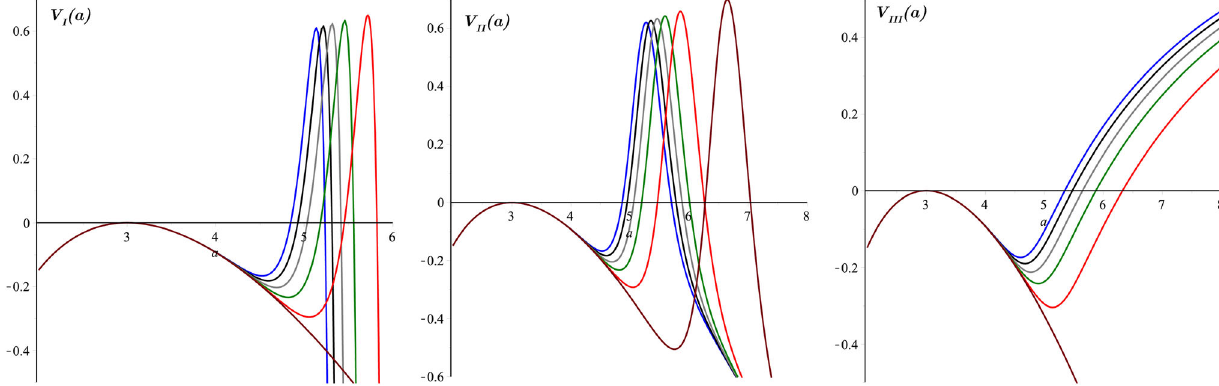
Fig. 10 Acloserlookatthepotentials V I , V II and V III withverysmall initial velocity i.e., v 0 (cid:3) 1 and a = 3 M , M = 1 and β 2 and − 16 for V I , V II and V III respectively. For all three potentials the value of the initial velocity varies from 0 . 0010 (the leftmost curve)